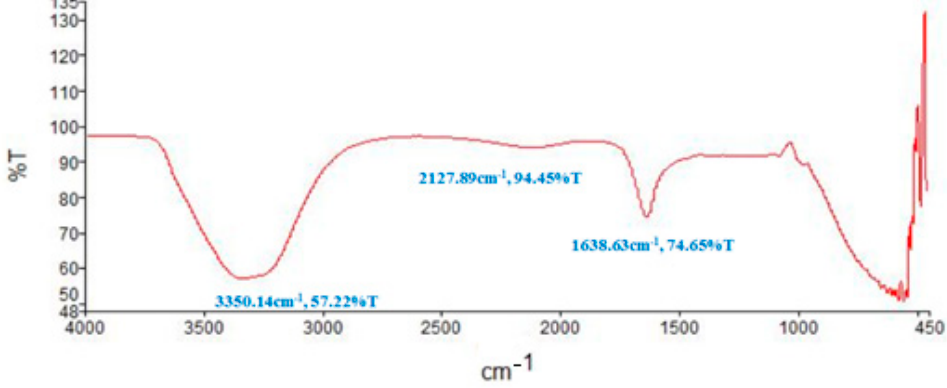
Figure 6. FTIR spectra of lysozyme functionalized AgNPs.